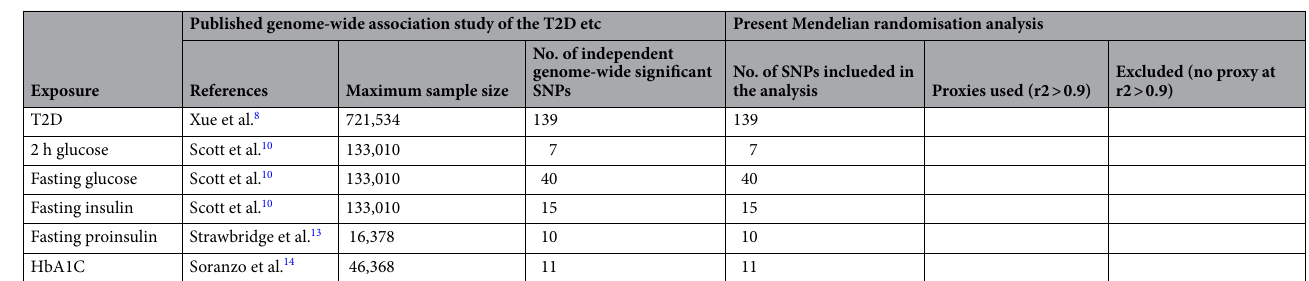
Table 1. Characteristics of instrumental variables used in the Mendelian randomisation analyses in European ancestry. SNPs single nucleotide polymorphisms, T2D type 2 diabetes, HbA1C hemoglobin